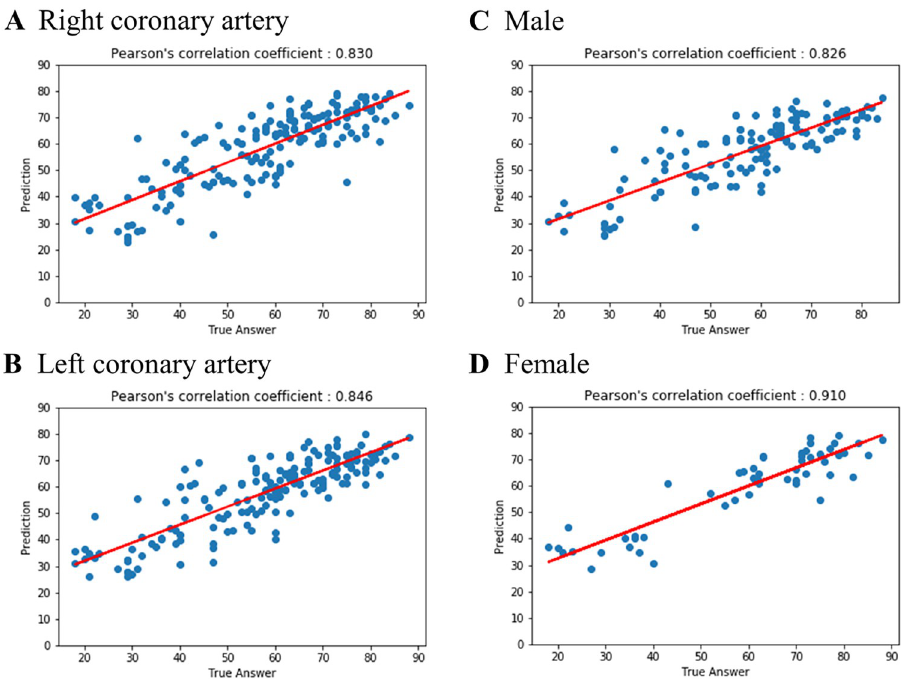
Fig 3. Predicted age based on CAG imaging versus chronological age in the subgroup analysis. Shown is the estimated vascular age versus the reported chronological age in the subgroup analysis (in years; red, regression line). A, right coronary artery; B, left coronary artery; C, male; D, female.